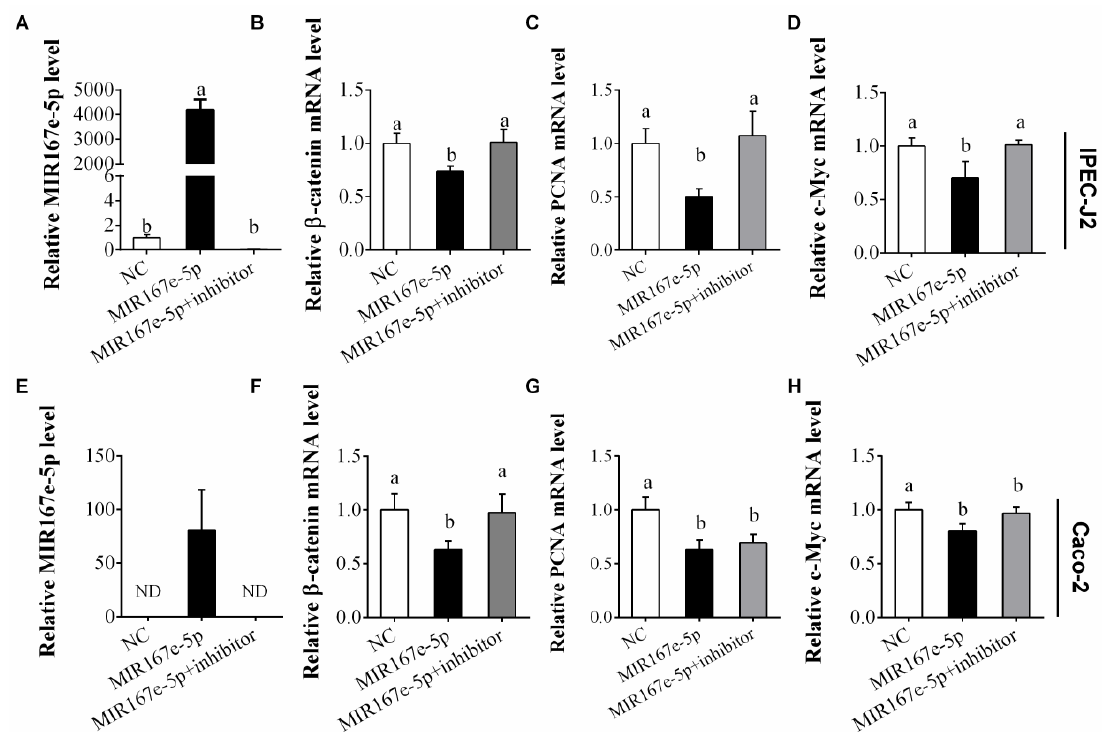
Figure 3. MIR167e-5p suppresses β -catenin, PCNA, and c-Myc mRNA expression. ( A,E ) qPCR analysis of relative MIR167e-5p levels in IPEC-J2 and Caco-2 cells after transfection with NC, MIR167e-5p, or MIR167e-5p + inhibitor (normalized against U6; n = 6). ( B – D ) qPCR analysis of relative β -catenin ( B ), PCNA ( C ), and c-Myc ( D ) mRNA levels in IPEC-J2 cells after transfection with NC, MIR167e-5p, or MIR167e-5p + inhibitor (normalized against β -actin; n = 6). ( F – H ) qPCR analysis of relative β -catenin ( F ), PCNA ( G ), and c-Myc ( H ) mRNA levels in Caco-2 cells after transfection with NC, MIR167e-5p, or MIR167e-5p + inhibitor (normalized against β -actin; n = 6). Statistical significance was determined by LSD tests. The same superscripts denote non-significant di ff erences ( p > 0.05), di ff erent superscripts denote significant di ff erences ( p < 0.05).